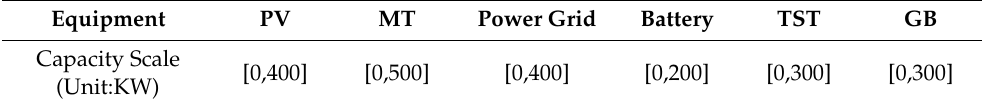
Table 1. Capacity range of each decision